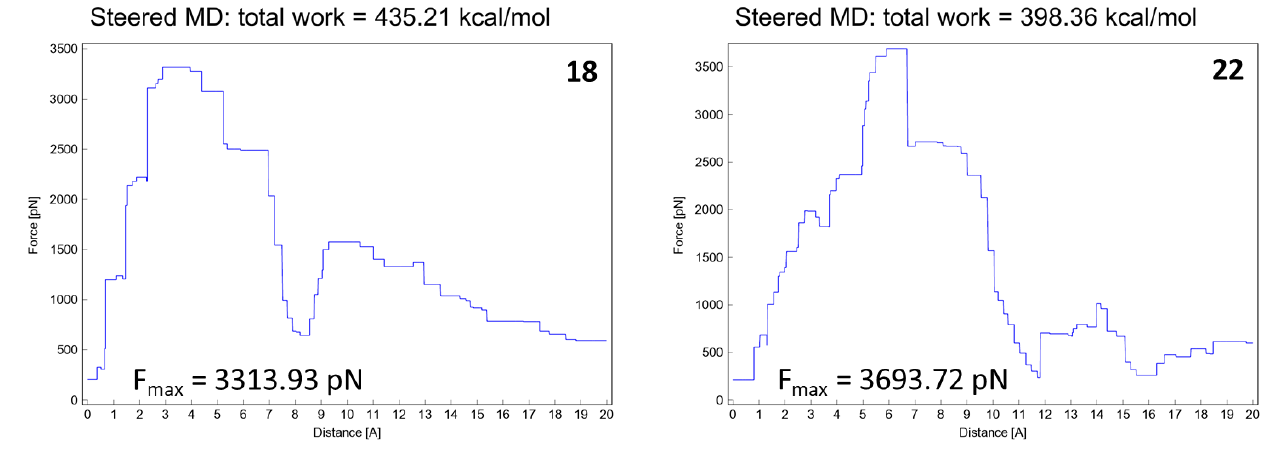
Figure 11. Total energies and F max from SMD experiments (20 Å) for molecules 18 and 22 .